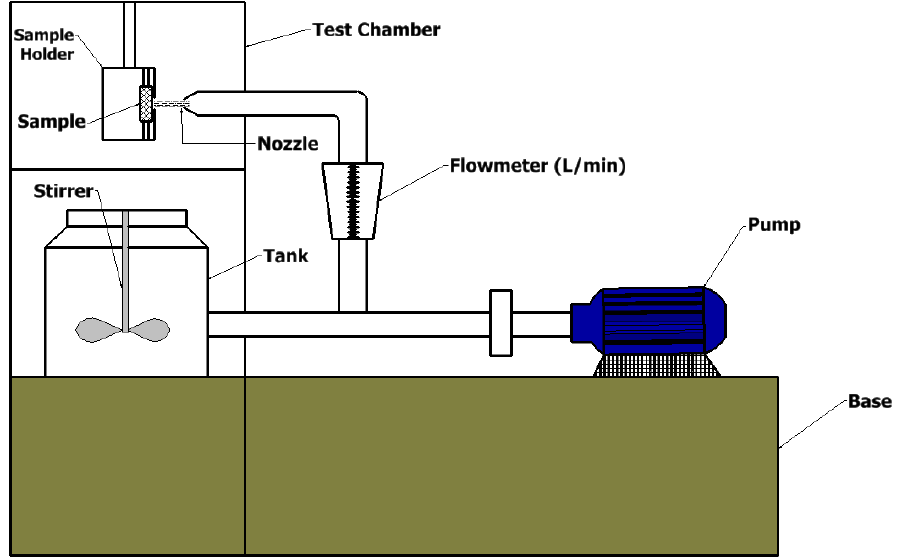
Figure 2. Erosion and correction device.